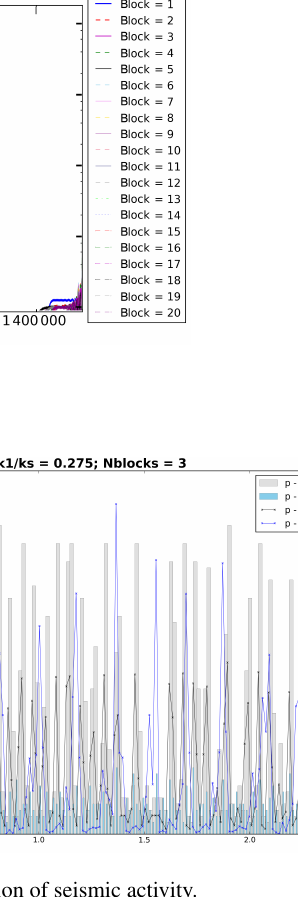
Figure 29. Time variation of seismic activity.